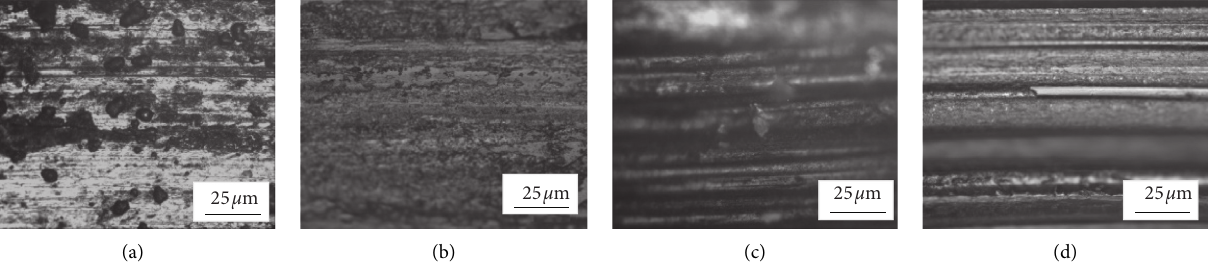
Figure 18: Worn morphologies of samples at room temperature: (a) H13 steel; (b) S0 coating; (c) S1 coating; (d) S2